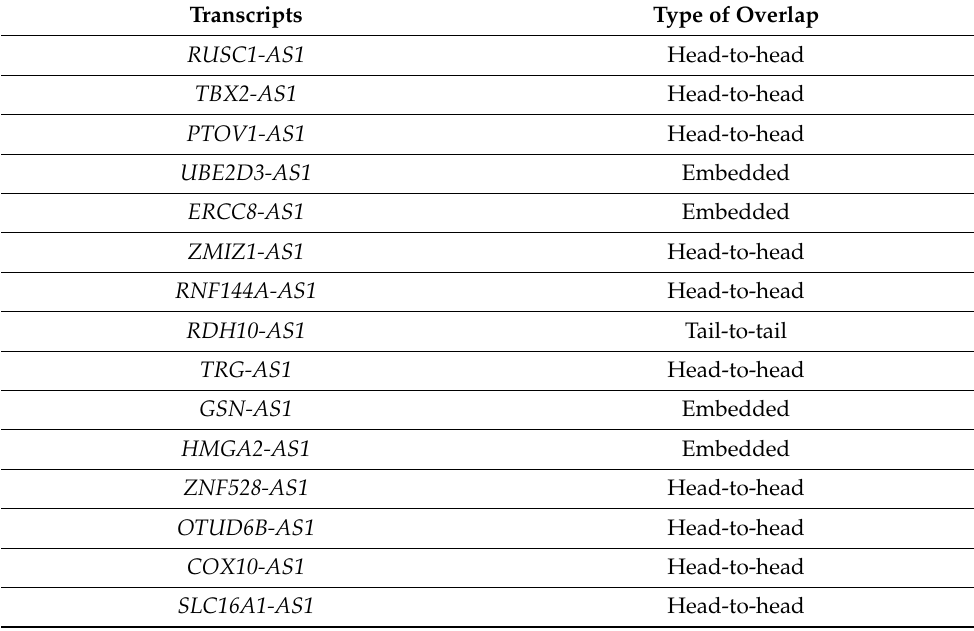
Table 4. Antisense lncRNAs and their type of overlap with sense